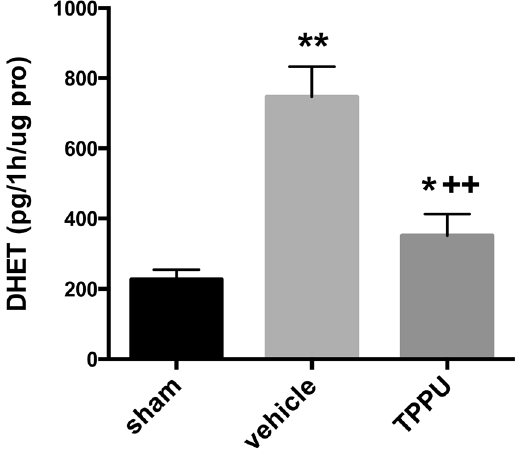
Figure 2. TPPU suppresses sEH activity. The 14,15-DHET production was measured as pg per h per µ g of protein (pro) by ELISA 1d after MCAO. Sham, MCAO with vehicle, and MCAO with TPPU groups were compared by ANOVA and the Holm-Sidak procedure for multiple comparisons (means ± SD; n = 4 rats per group; * p < 0.05 vs. sham group; ** p < 0.01 vs. sham group; ++ p < 0.01 vs. vehicle group).